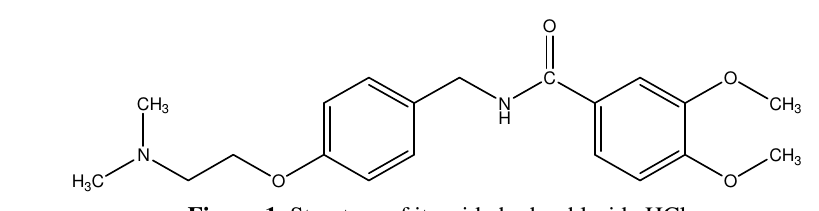
Figure 1. Structure of itopride hydrochloride HCl